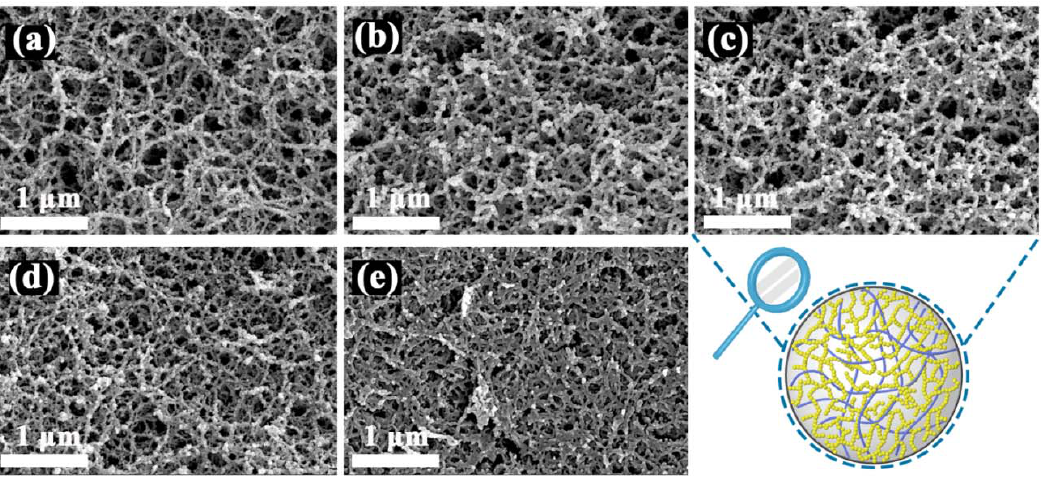
Figure 4. SEM images of ( a ) SCAB-8, ( b ) SCAB-9, ( c ) SCAB-10, ( d ) SCAB-11, ( e ) SCAB-12.